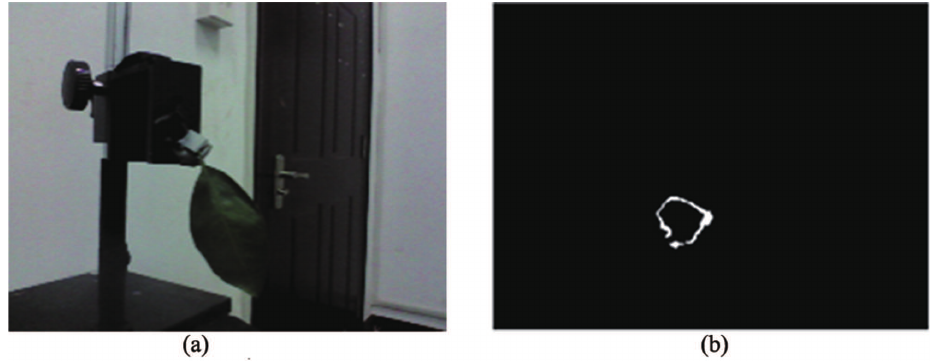
Figure 21. Color image of curly leaf and corresponding depth-sphere intersection curve: ( a ) color image; ( b ) intersection